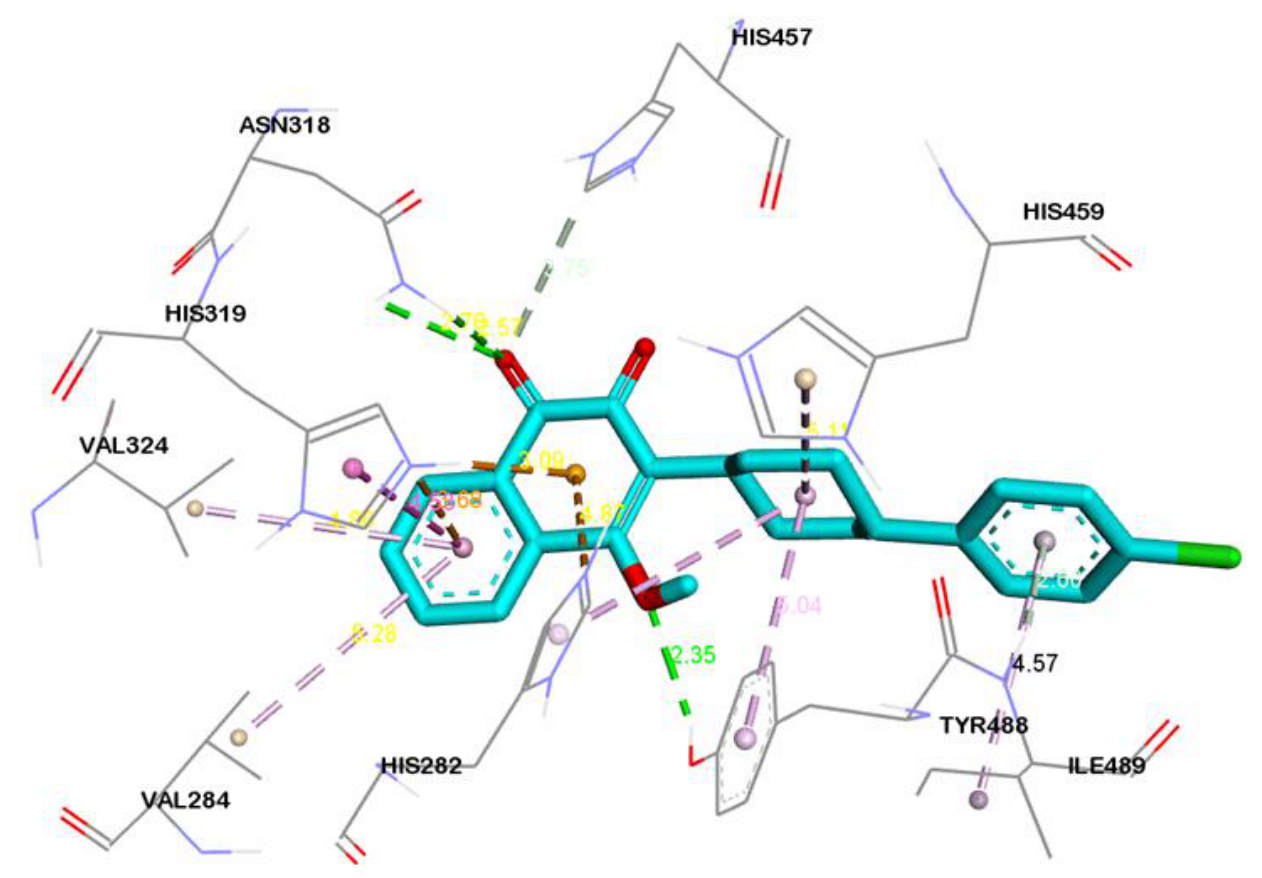
Figure 7. 3D interaction diagram showing molecular interactions of Atovaquone with the amino acids (grey) mainly involved in the binding pocket identified. Molecular interactions include conventional hydrogen bond (green), carbon hydrogen and pi–donor hydrogen bond (pale green), pi–cation (tangerine), pi–pi T-shaped (rose pink), and alkyl and pi–alkyl (light pink). Table 2. Table displaying docking interactions and bond distances of the top scoring ligands with the active site of the target